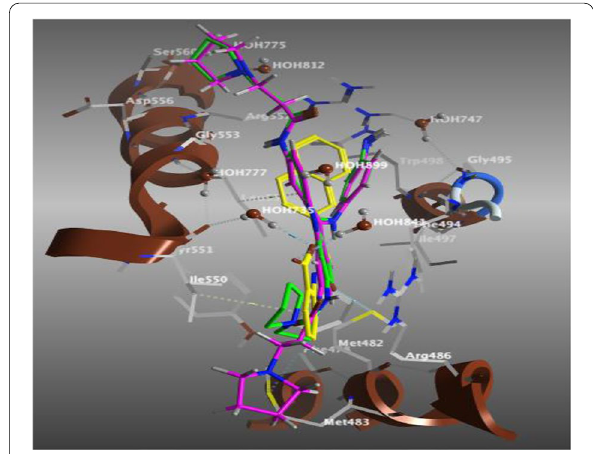
Fig. 14 Depiction of 3D interaction of compound 82 pose 2 (pink) with TERT and flexible alignment with pose 1 of compound 82 (green) and crystallized ligand BIBR1532